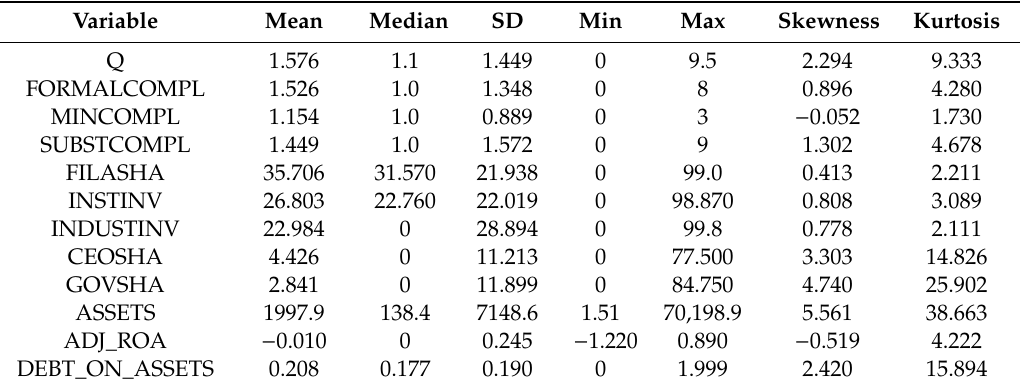
Table 7. Descriptive statistics of variables, and untransformed variables.